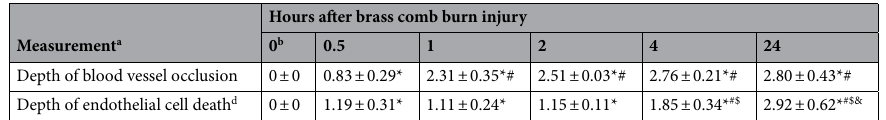
Table 1. Depth of blood vessel occlusion and endothelial cell death. a millimeters, b setting up as controls (normal pigskin with no brass comb burn; c defined as the deepest vertical (from epidermal basement) location of visibly dilated venules and/or arterioles filled with denatured clots on burn sites of HPS trichrome stained skin wound sections; d defined as the deepest vertical (from epidermal basement) location of positively labeled blood vessels on burn sites of vimentin-IHC stained skin wound sections. * p < 0.005–0.0001, versus corresponding controls (0 h); # p < 0.003–0.0001, versus corresponding 0.5 h; $ p < 0.003–0.0001, versus corresponding 1 h and 2 h; & p < 0.03, versus 4 h.